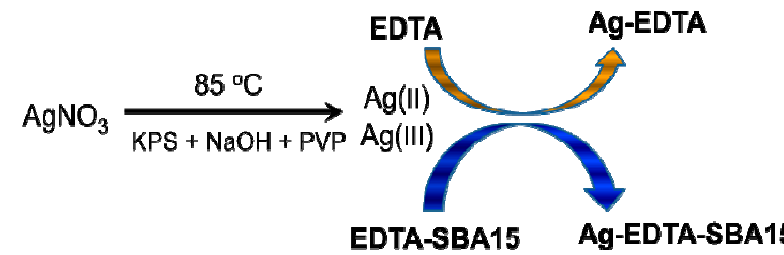
Figure 1. Synthesis of high valence Ag composites.